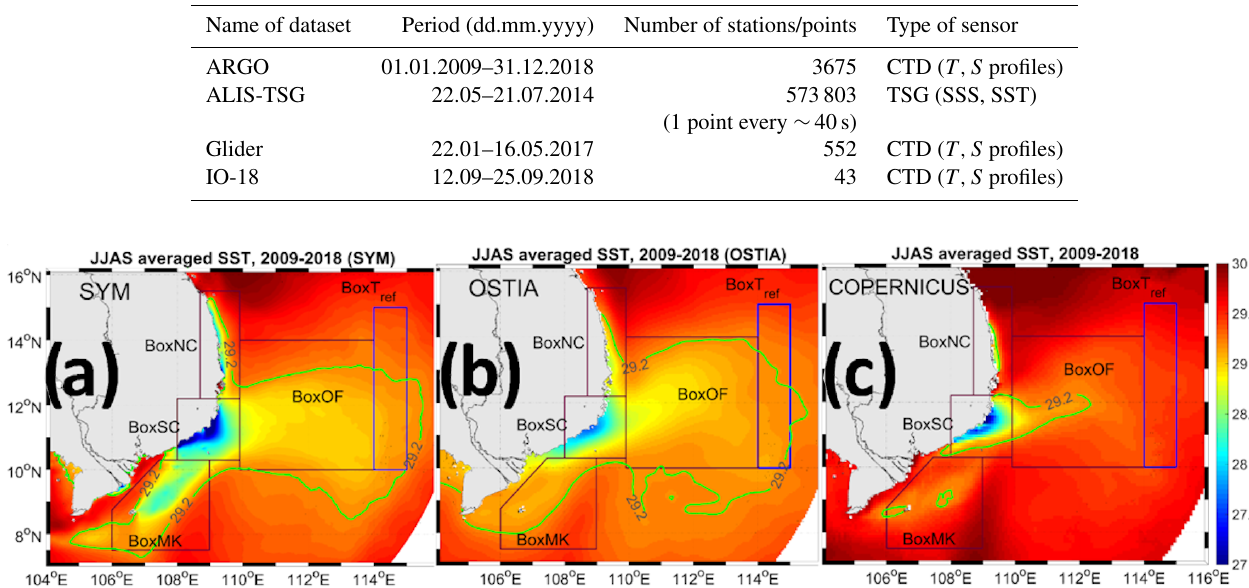
Figure 3. JJAS average over 2009–2018 of SST ( ◦ C) from (a) SYMPHONIE, (b) OSTIA, and (c) COPERNICUS over the SVU region. Black boxes show the four upwelling areas, and the blue rectangle shows the reference box. Coordinates of the boxes: BoxNC